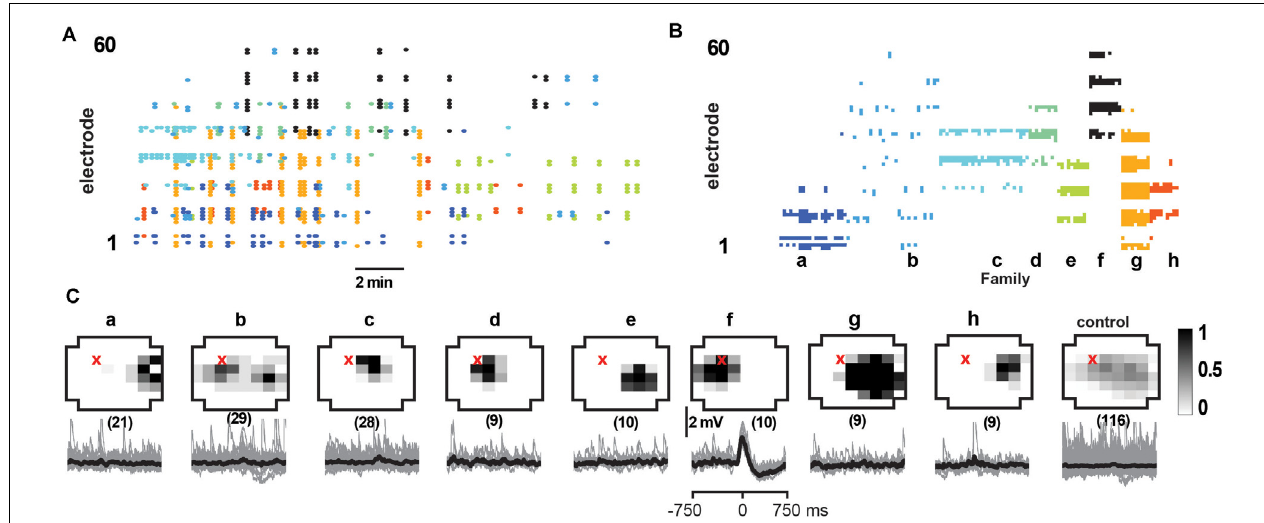
FIGURE 7 | Select responses in layer 2/3 pyramidal neurons to families of NMDA/DA induced LFP avalanches. (A) nLFP raster on the MEA with color-coded avalanche families and their temporal occurrences during spontaneous activity (15 min recording, mPFC). (B) Corresponding family-sorted avalanche raster. (C) Top: average spatial LFP pattern for all avalanche families. Grayscale indicates the fraction of site participation for each family. The red cross marks the soma location of the patched pyramidal neuron. Control includes all avalanches except those in family f . Bottom: family-triggered average intracellular membrane potential time course ( black ). The number in brackets indicates family members. Pre-averaged individual traces are shown in gray . Family f generated reliable input to the patched cell. Corresponding control demonstrates no reliable trigger with other family patterns outside f .